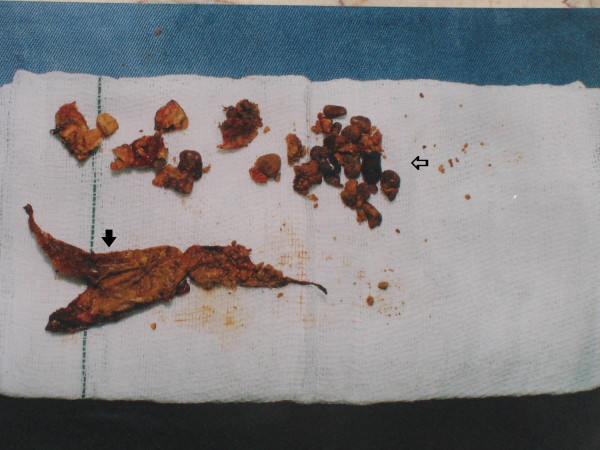
Obstructing materials. Bezoar material in the shape of a CBD cast (solid arrow) and multiple stones (open arrow) removed from the dilated common bile duct by surgery.